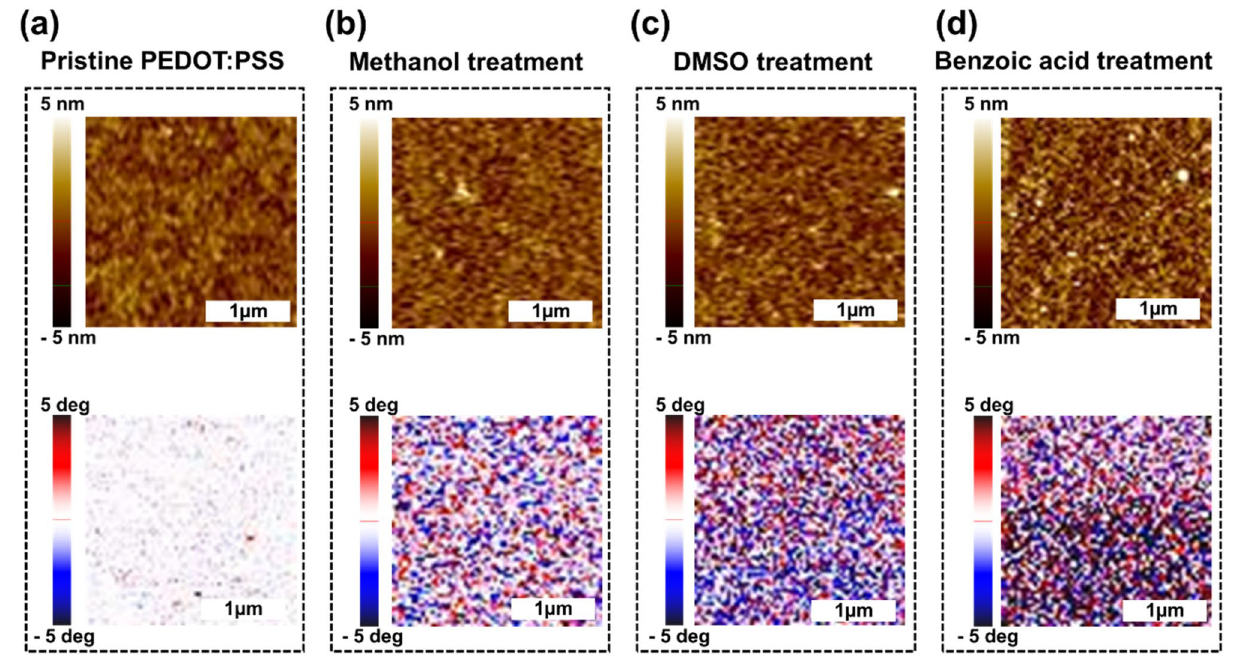
Figure 5. Atomic force microscope topography images of ( a ) pristine PEDOT:PSS, and PEDOT:PSS with ( b ) methanol, ( c ) DMSO, and ( d ) benzoic acid treatments, and phase images of ( e ) pristine PEDOT:PSS, and PEDOT:PSS with ( f ) methanol, ( g ) DMSO, and ( h ) benzoic acid treatments (Kang et